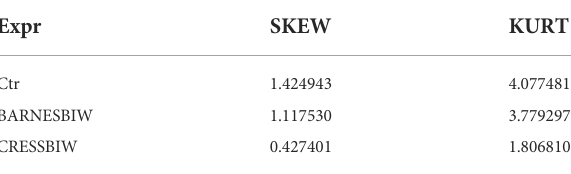
TABLE 4 Skewness and kurtosis of each product of Ctr, CRESS, and